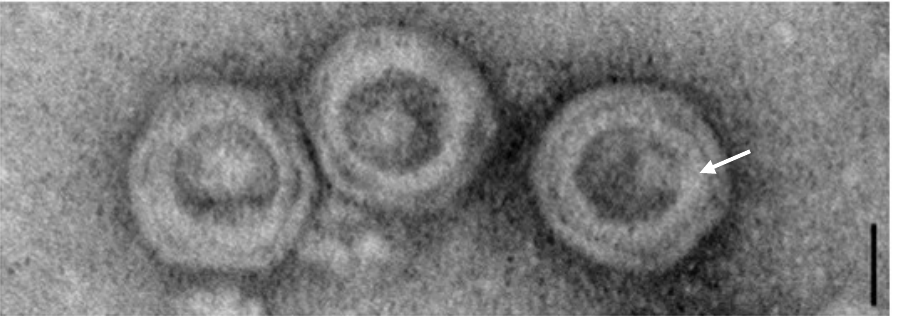
Figure 6. Transmission electron micrograph of phage Wip1 particles negatively stained with 2% uranyl acetate. Phage Wip1 has the typical tail-less isometric heads of Tectiviridae with an internal lipid membrane (highlighted by the arrow). Scale bar represents 25 nm. Reproduced from Schuch et al. (2009), PLoS One (reference